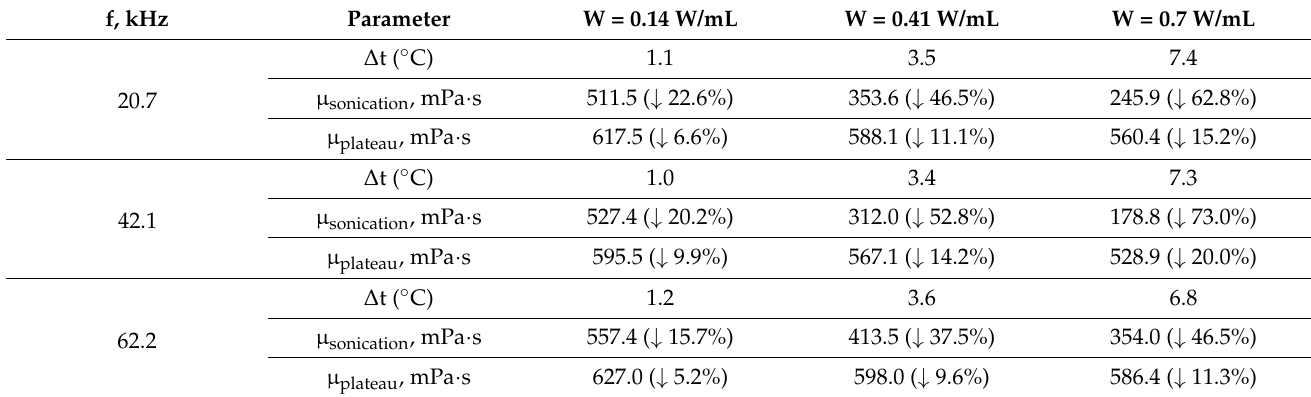
Table 1. The viscosity of the heavy crude oil sample and change in temperature of the medium under different ultrasonic modes.